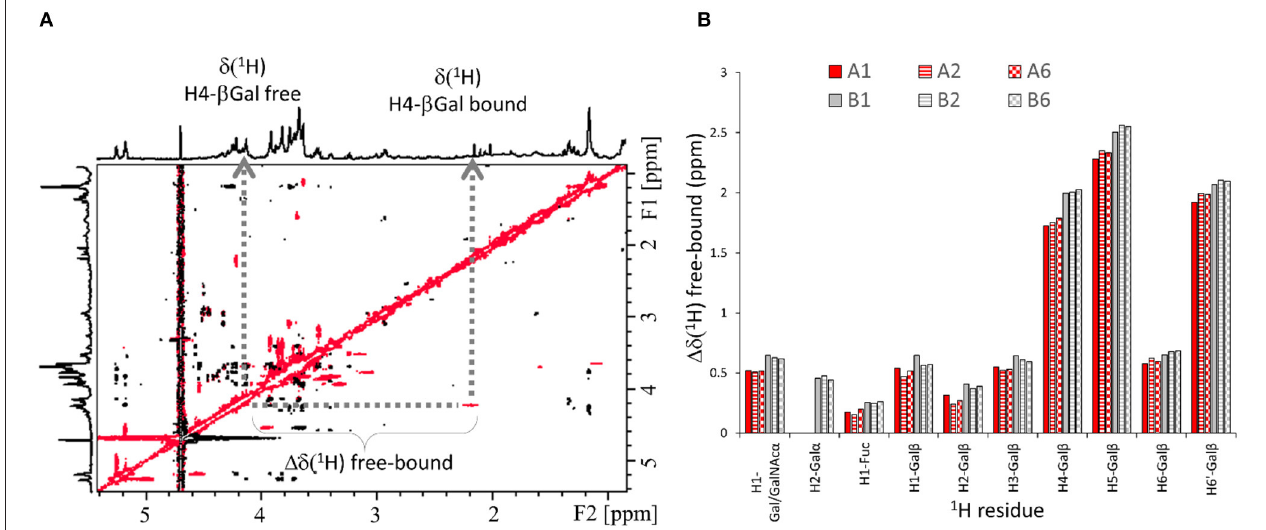
FIGURE 3 | 1 H-NMR-based ligand chemical exchange (EXSY) analysis from the trROESY experiments. (A) trROESY spectrum of the B type-6 tetrasaccharide antigen in the presence of Gal-4N (molar ratio 20:1). The cross-peaks in black correspond to those arising from regular nuclear Overhauser effects in the rotating frame, while those in red arise from chemical exchange. Their chemical shifts at the different 1 H dimensions in the 2D spectrum correspond to those in the free (down-field) and bound (up-field) states. (B) Plot for the measured differences in chemical shifts between the free and bound states ( 1 δ [ 1 H] free-bound) for those selected protons of the antigens that experience slow exchange in the ROESY spectrum in the presence of the